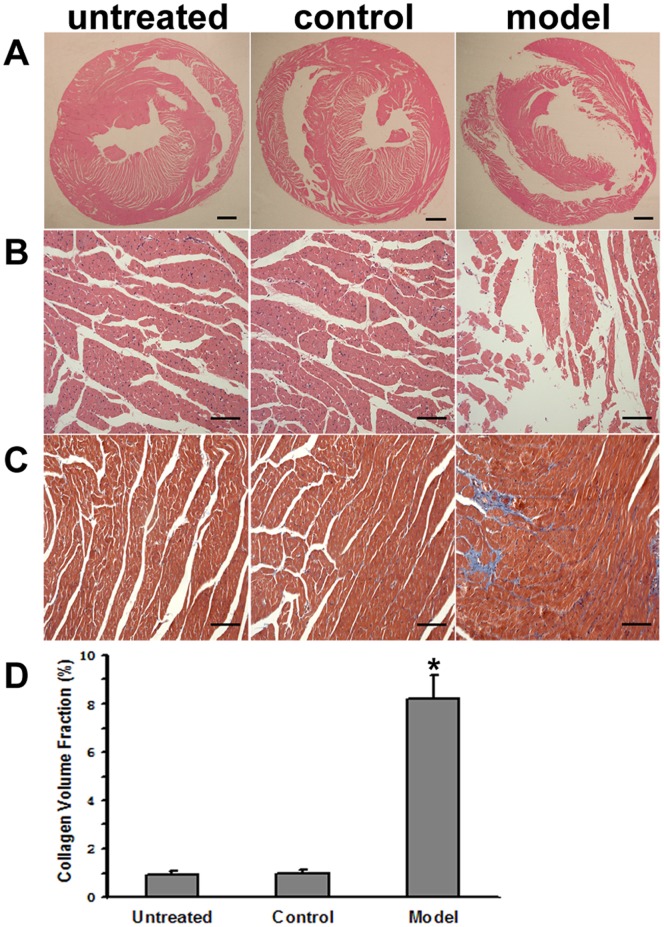
Histopathological changes in the rat hearts.A: Representative macroscopic transversal sections of hearts. The right and left ventricle of DCM hearts are dilated and the LV wall thickness is decreased. Scale bar = 1 mm. B: Photomicrographs show representative myocardial sections stained with HE. Myocardial architecture is intact with cardiomyocytes lined up in order in the untreated and control groups. Myofibrils are widely disintegrated, accompanied by multifocal degeneration and myocytolysis with diffused lymphocytes and monocytes infiltration in the model group. Scale bar = 0.1 mm. C: Photomicrographs show representative myocardial sections stained with Masson’s trichrome. Obvious heart fibrosis is observed in the model group. Scale bar = 0.1 mm. D: Quantitative analysis demonstrated that the collagen volume fraction in the model group (n = 16) was significantly greater than that in the untreated (n = 6) or control group (n = 9). *P<0.05 versus the control group.